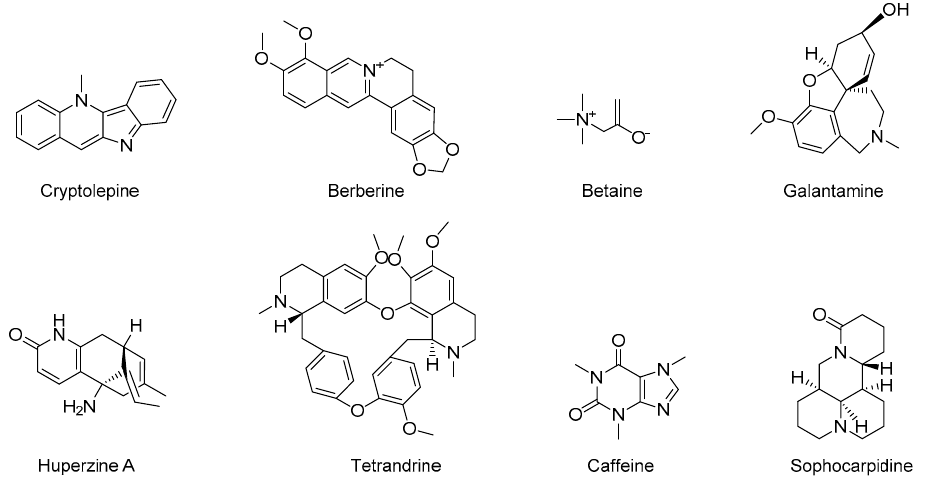
Figure 4. Chemical structure of natural alkaloids with anti-inflammatory